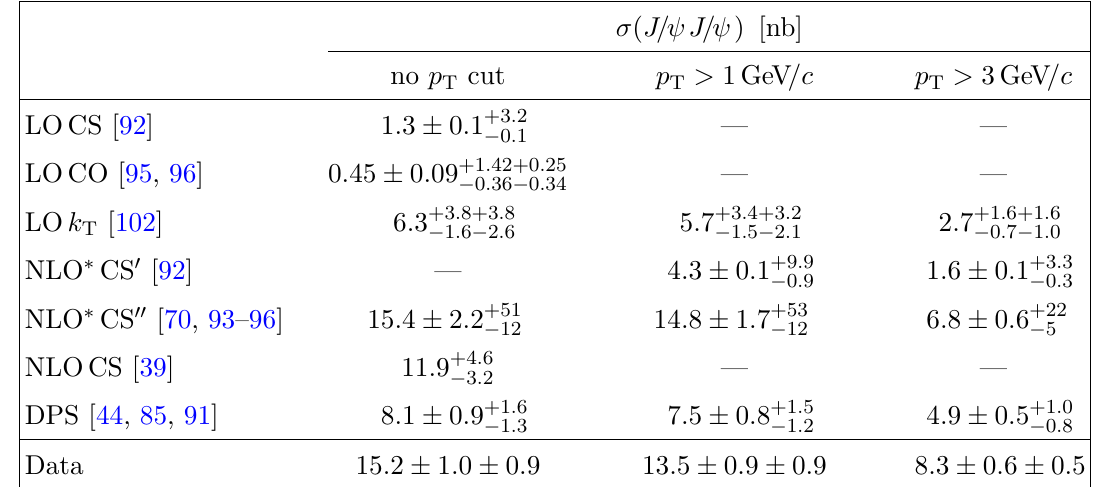
Table 2. Summary of the theoretical predictions and the measurement of (cid:27) ( J= J= ) for di(cid:11)erent regions of transverse momentum of the J= pair. For SPS predictions, the (cid:12)rst uncertainty accounts for the variation of PDFs and gluon densities, while the second one corresponds to the variation of the factorisation and renormalisation scales. For the LO CO predictions the third uncertainty corresponds to the choice of LDMEs from refs. [25, 113{119]. For NLO CS predictions [39] the un- certainty corresponds to the variation of the factorisation and renormalization scales. For the DPS prediction the (cid:12)rst uncertainty is due to the measured prompt J= production cross-section [85]